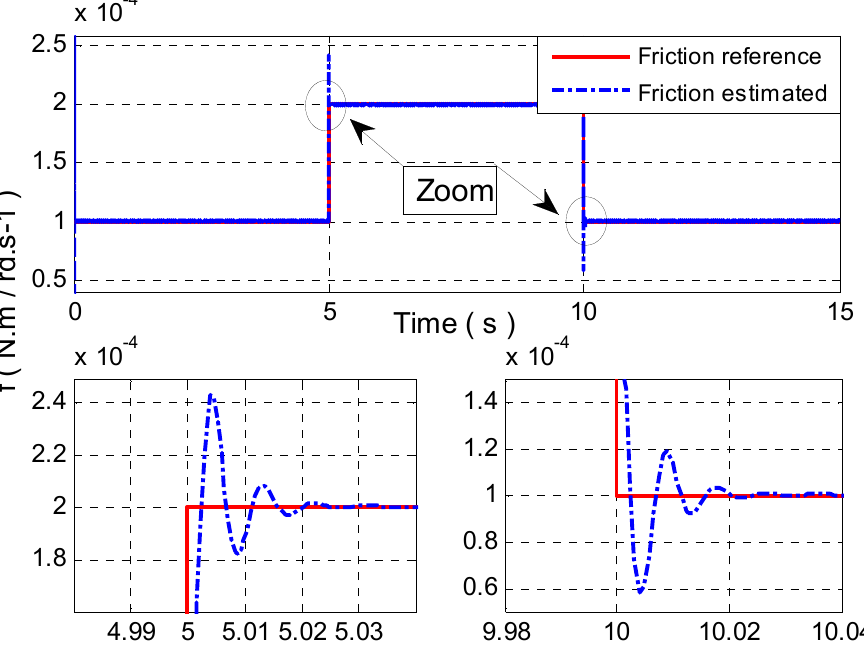
Figure 10. Estimated friction and its reference value, with zoom. The overshooting occurring at the transient moment represents 20% of the reference value, which is an acceptable value where the response time is 20